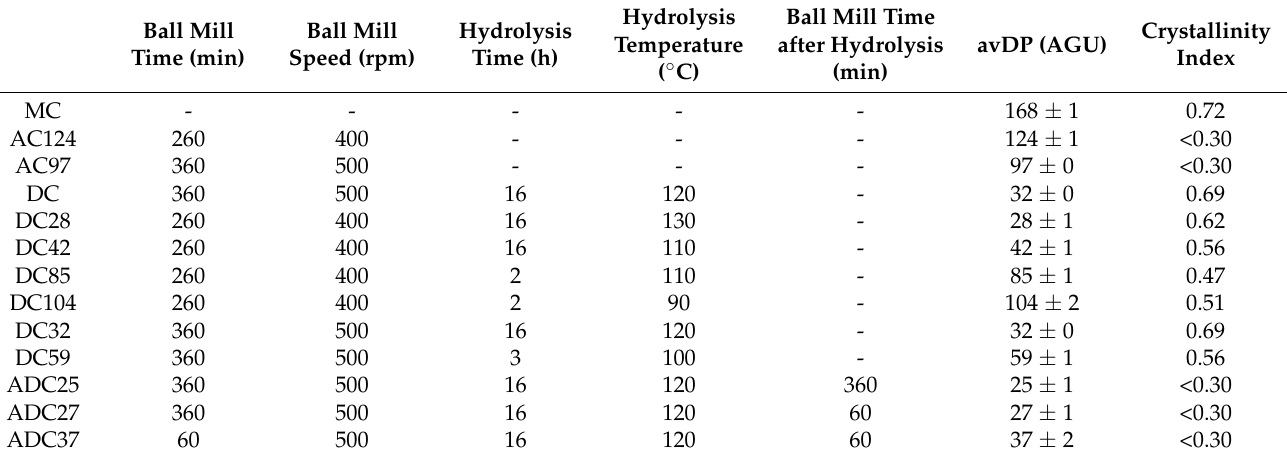
Table A1. Ball mill and hydrolysis conditions for different AC, DC and ADC samples, and their corresponding average degree of polymerization (avDP) and crystallinity index. ACxx, DCxx or ADCxx represents amorphized cellulose, depolymerized cellulose or amorphized depolymerized cellulose with an average degree of polymerization of xx.